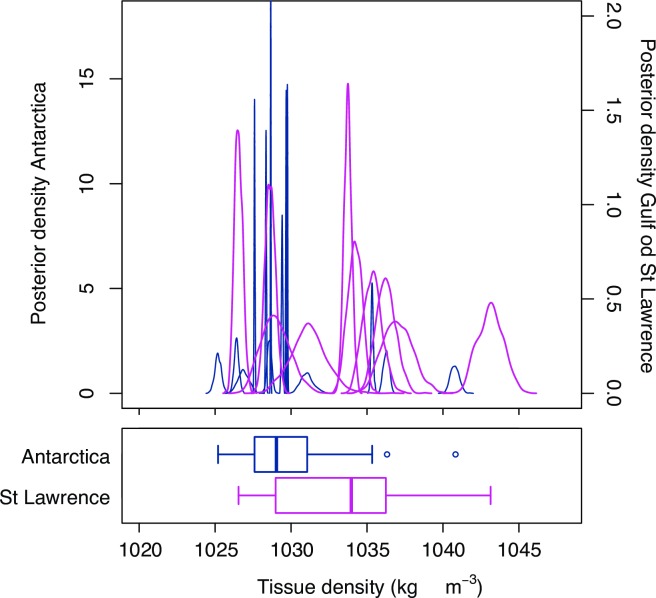
Tissue density estimates from the best model with the lowest DIC.The top panel shows posterior distribution of individual body tissue density for each tag deployment. Blue and magenta lines indicate whales from Antarctica and the Gulf of St Lawrence, respectively. Box plots in the bottom panel show median and interquartile range of tissue density estimates from each location.